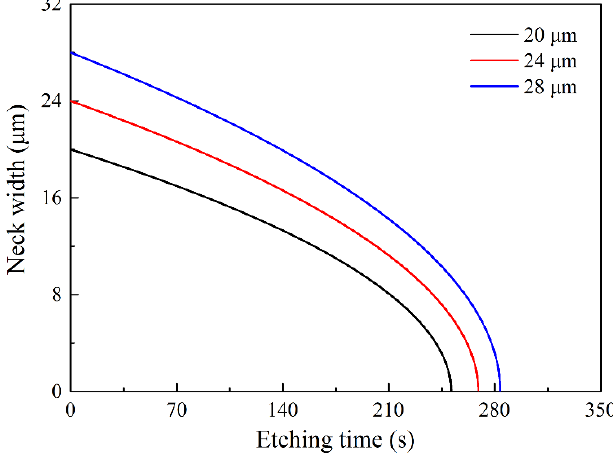
Figure 8. Dependence of the neck widths on the etching time for the circular masks with di ff erent sizes.